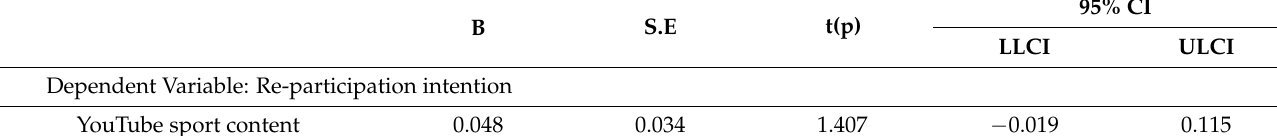
Table 3. Interaction effect